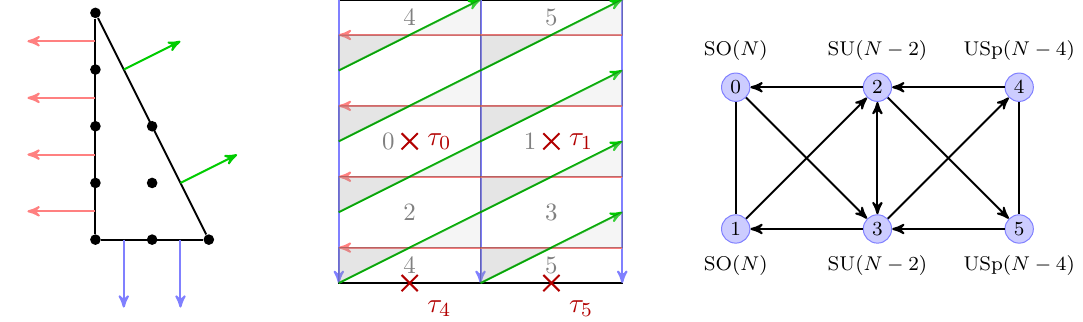
Figure 32. The model L 0 , 4 , 0 / Z 2 . On the left the toric diagram is drawn, at the center the five- brane and its orientifold projection with fixed points, on the right the quiver resulting from the orientifold projection.